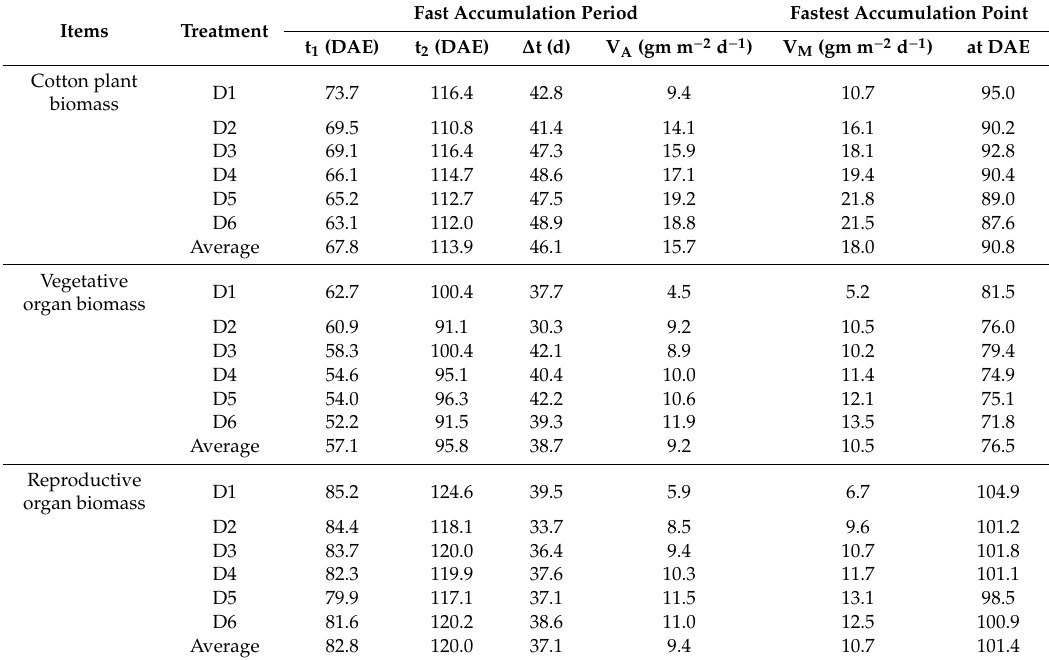
Table 5. Eigen values of cotton biomass accumulation at growing season 2016.